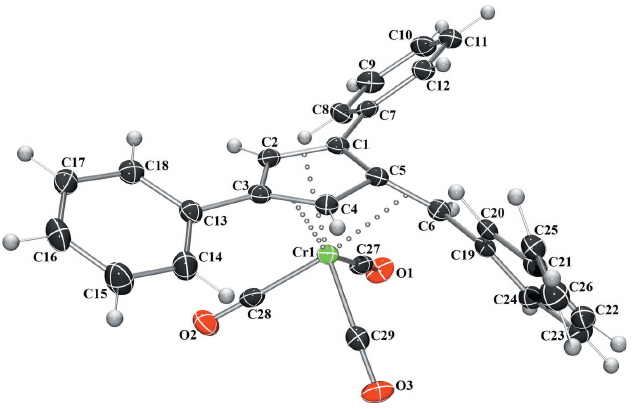
Figure 2 The molecular structure of II . Displacement ellipsoids are shown at the 50% probability level.